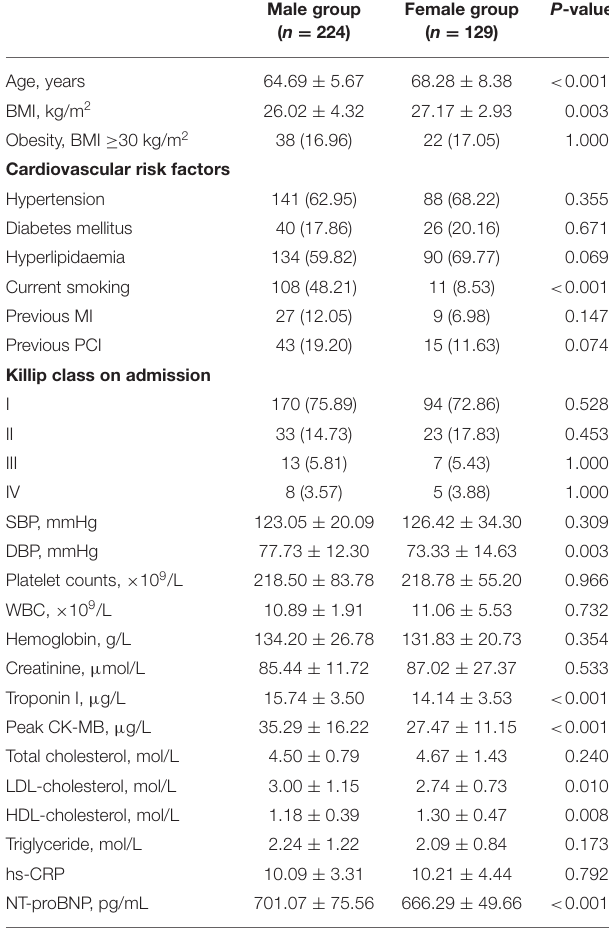
TABLE 1 | Patient demographics and clinical